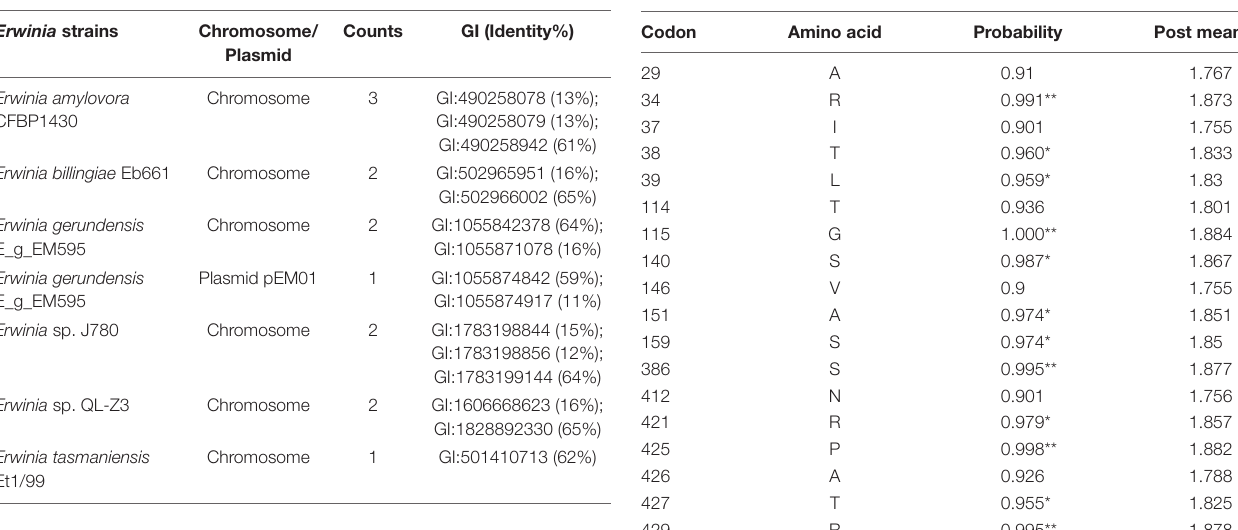
TABLE 5 | Bayes Empirical Bayes analysis of positively selected sites identified in lacY of Erwinia sp. E602 with the branch-site model A. Model